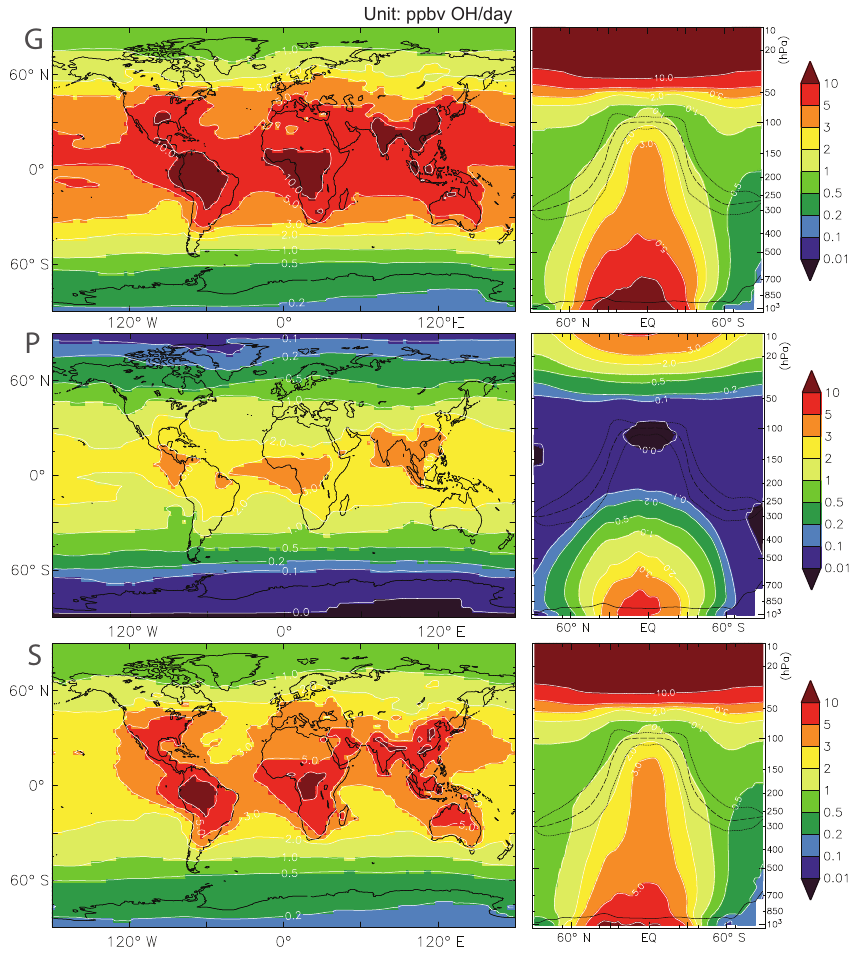
Figure 7. Annual mean OH formation in the troposphere (left) and up to 10hPa (right). The top panels show total ( G ), the middle panels primary ( P ) and the bottom panels secondary ( S ) OH formation (in ppbvday − 1